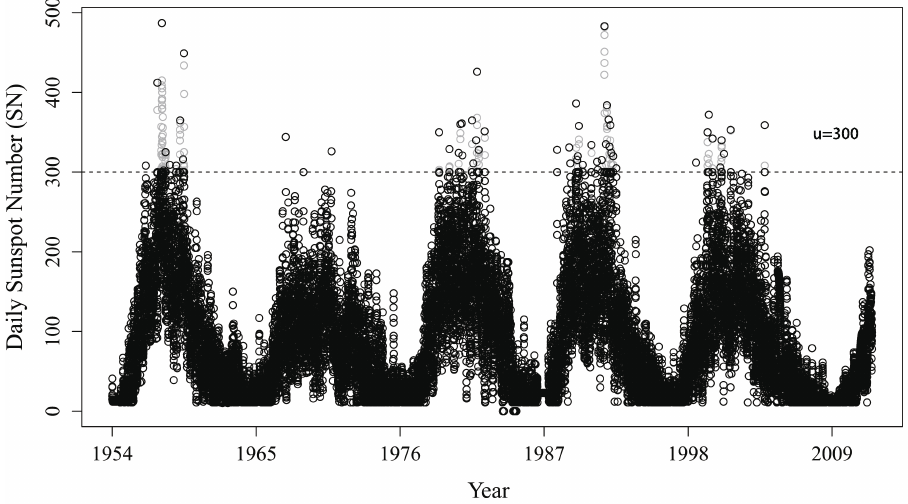
Figure 8. Decluster data above a threshold and the new independent threshold exceedances are obtained.